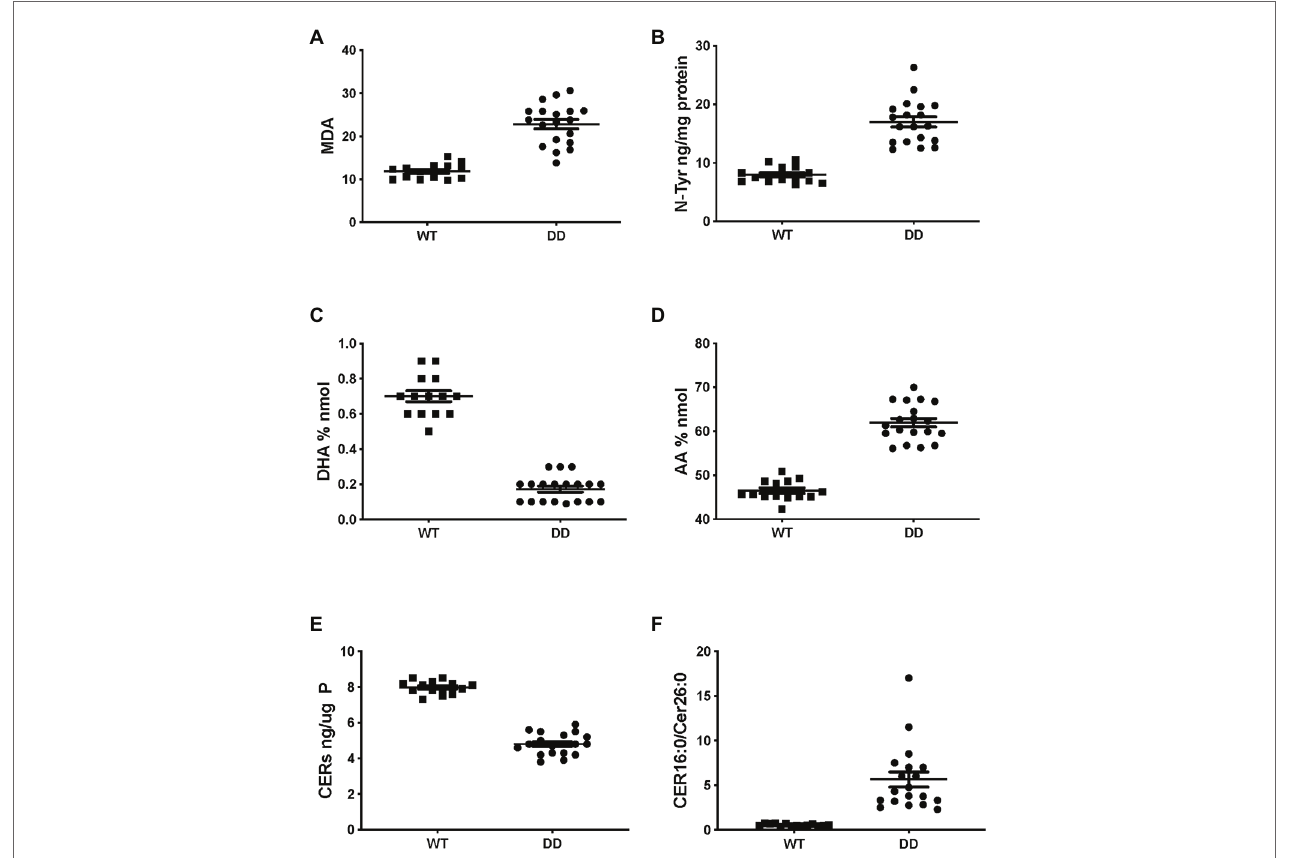
FIGURE 4 | Oxidative stress and abnormal lipid levels in F508del CFTR variant mouse lung. Total lungs from adult male and female mice, homozygous for the F508del CFTR allele (DD, N = 19) or age- and sex-matched normal littermates (WT, N = 14), were extracted and lipids were analyzed as described, each data point represents a single individual. (A) malondialdehyde (pmol/nmol fatty acid). (B) Nitro-tyrosine. (C) DHA. (D) AA. (E) Total ceramide species after TLC purification. (F) LCC(Cer16:0)/VLCC(Cer26:0) ratio (compare Figure 2C ). CF and WT lungs differed significantly in all parameters (unpaired T -test p <